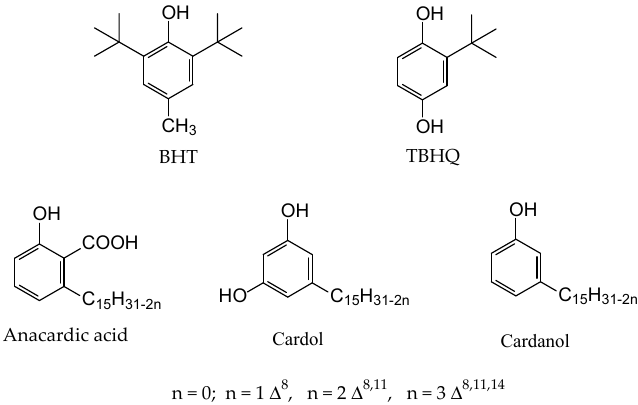
Figure 7. Chemical structure of synthetic antioxidants (butylated hydroxytoluene (BHT) and butylated hydroxyquinone (TBHQ)) and the main constituents of the cashew nut shell liquid (CNSL). TBHQ and BHT are primary antioxidants that interrupt oxidative reactions in the chain, by the donation of hydrogens atoms from phenolic hydroxyl to the free radicals of esters, later becoming